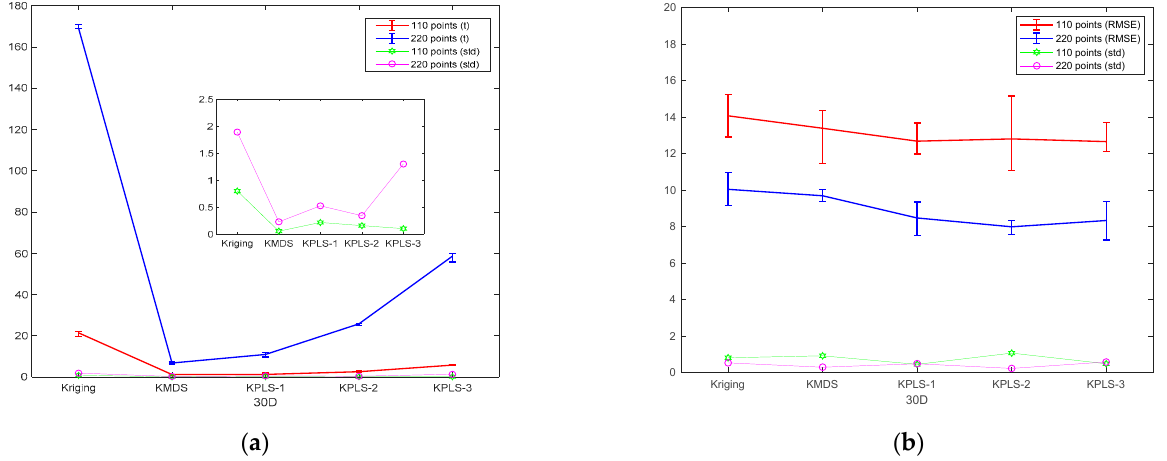
Figure 5. ( a ) Modeling time and its standard deviation for the 30D Griewank function. ( b ) RMSE and its standard deviation for the 30D Griewank function.